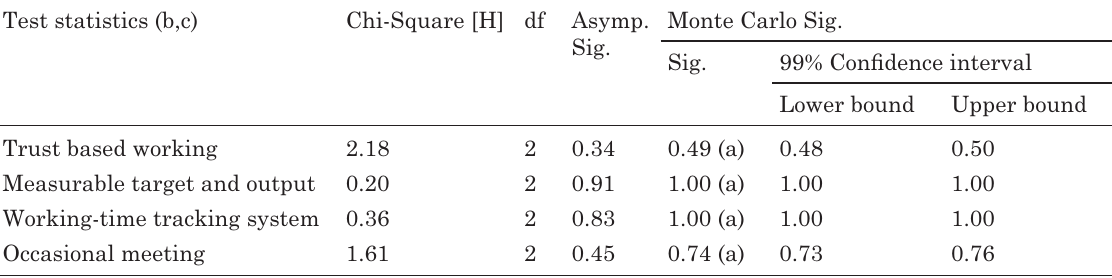
Table 10. Kruskal Wallis Test of monitoring fl exible working staff Test statistics